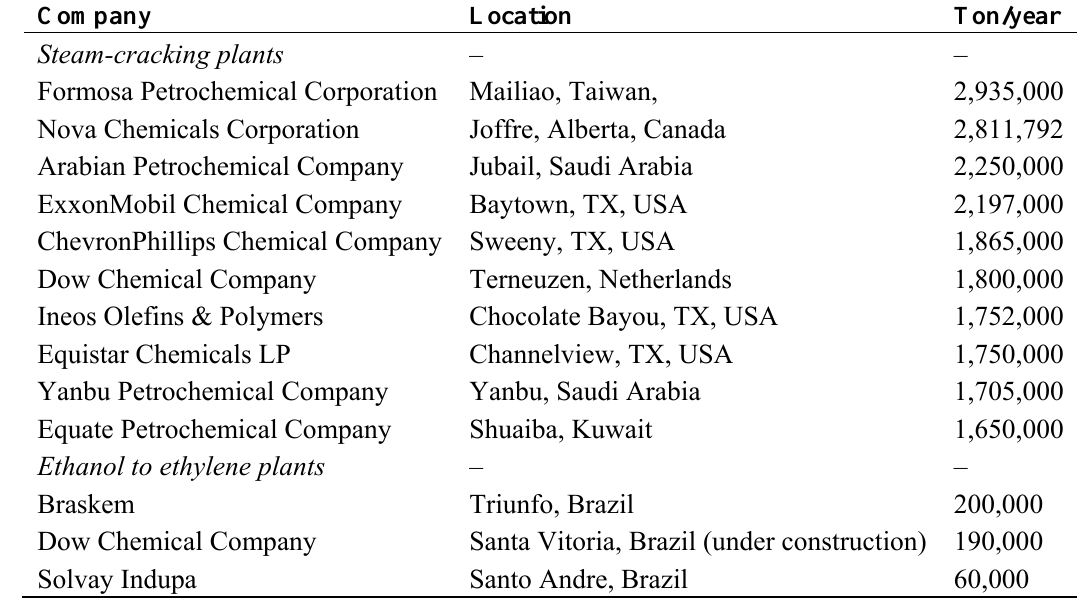
Table 1. Top industrial ethylene complexes and their locations ranked by capacity (tons of ethylene produced per